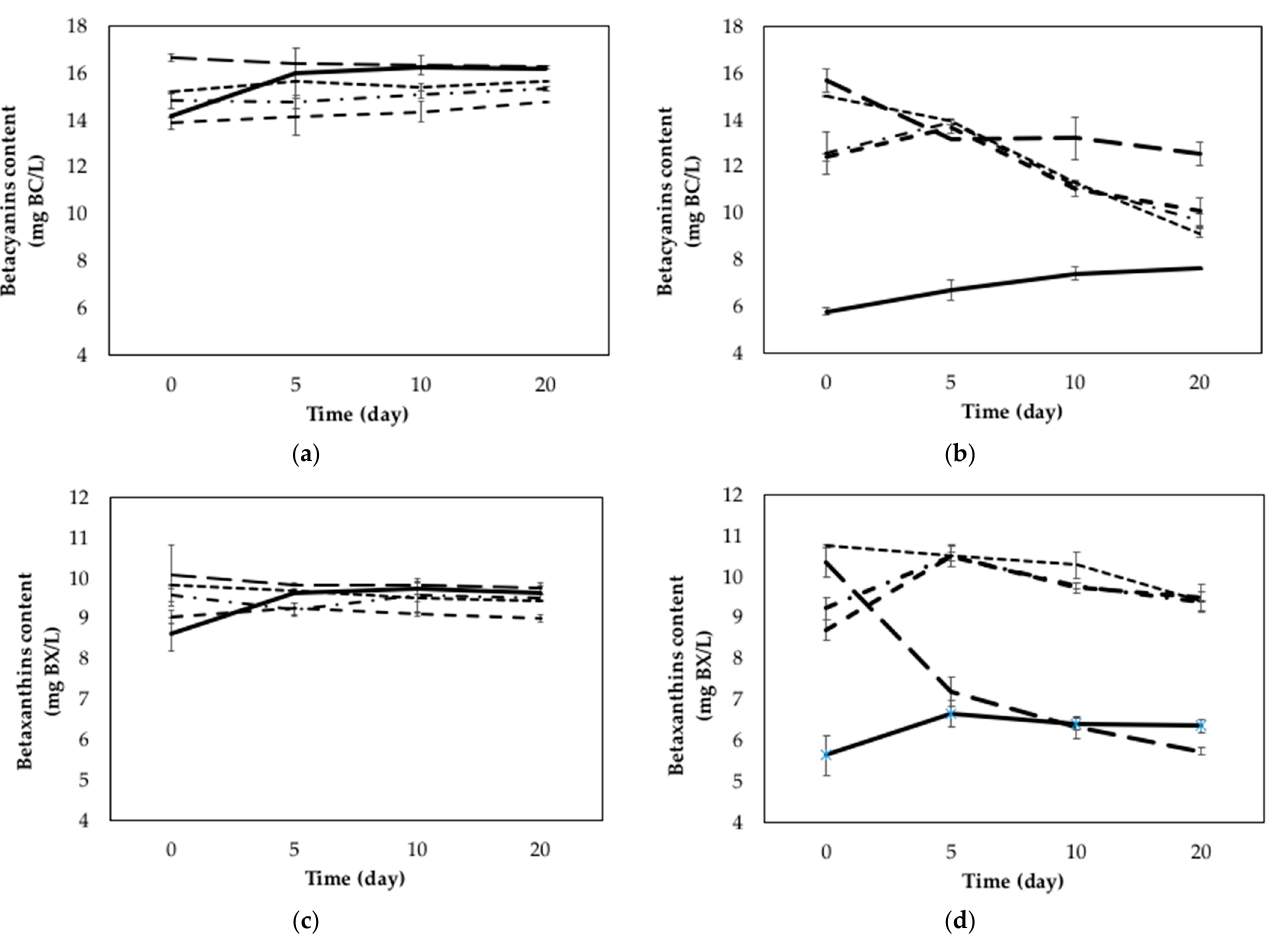
Figure 4. Effect of UV-C irradiation and thermal treatment (HTST or UHT) on betalains (mg/L) in red prickly pear juice: ( a ) betacynins in juice at pH 3.6 ( b ) betacynins in juice at pH 7.0 ( c ) betaxanthins in juice at pH 3.6 ( d ) betaxanthins in juice at pH 7. — Thermal treatment ——Juice